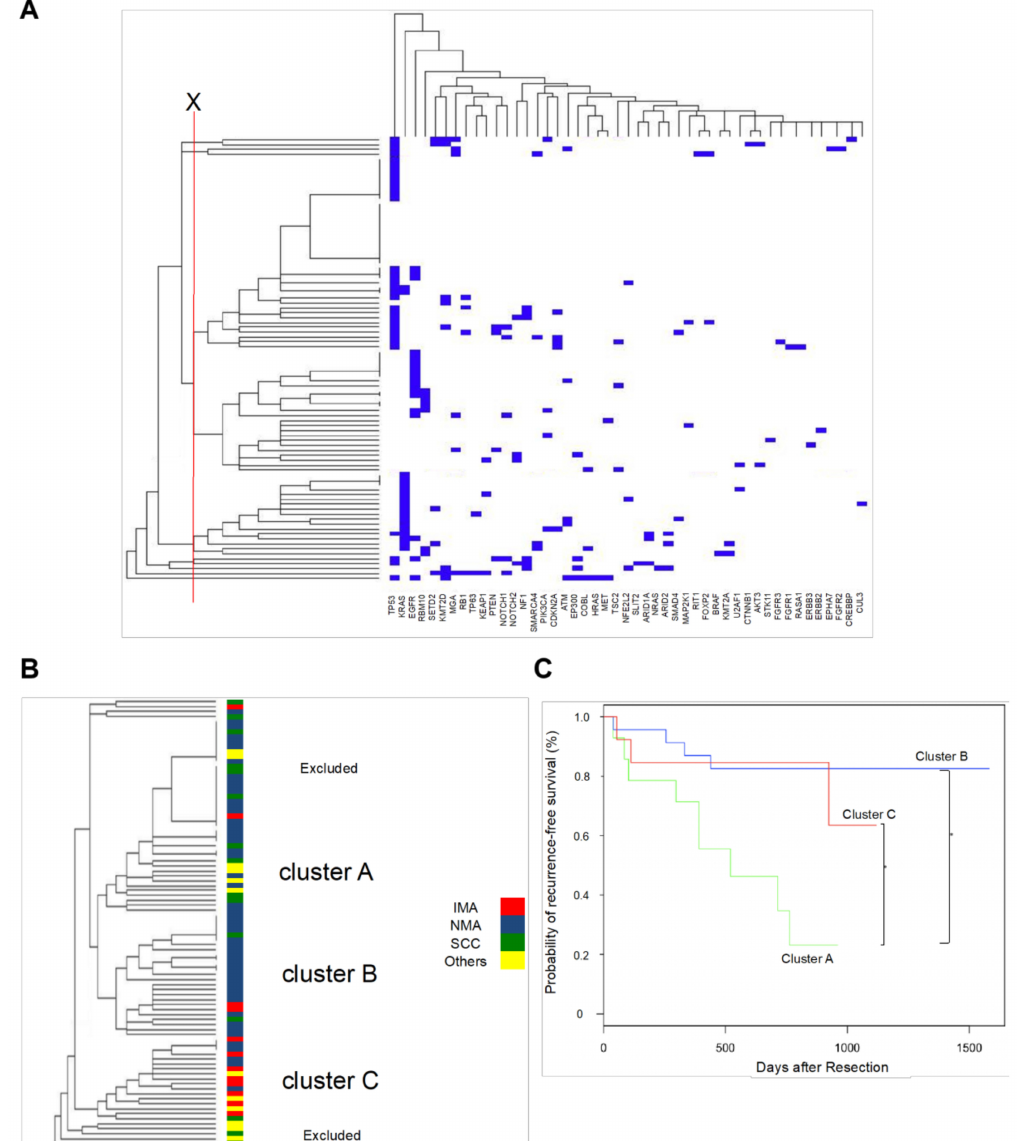
Figure 2. Hierarchical clustering of lung cancer. ( A ) Full view of the cluster diagram. Unsupervised hierarchical clustering was used to group correlated mutations into several clusters, which were assigned based on the threshold marked in red. Results were visualized in TreeView, with mutations on the horizontal axis and cases on the vertical axis. Cases and mutations are arranged such that the most similar are placed next to each other. The length of branches connecting cases or mutations is inversely proportional to profile